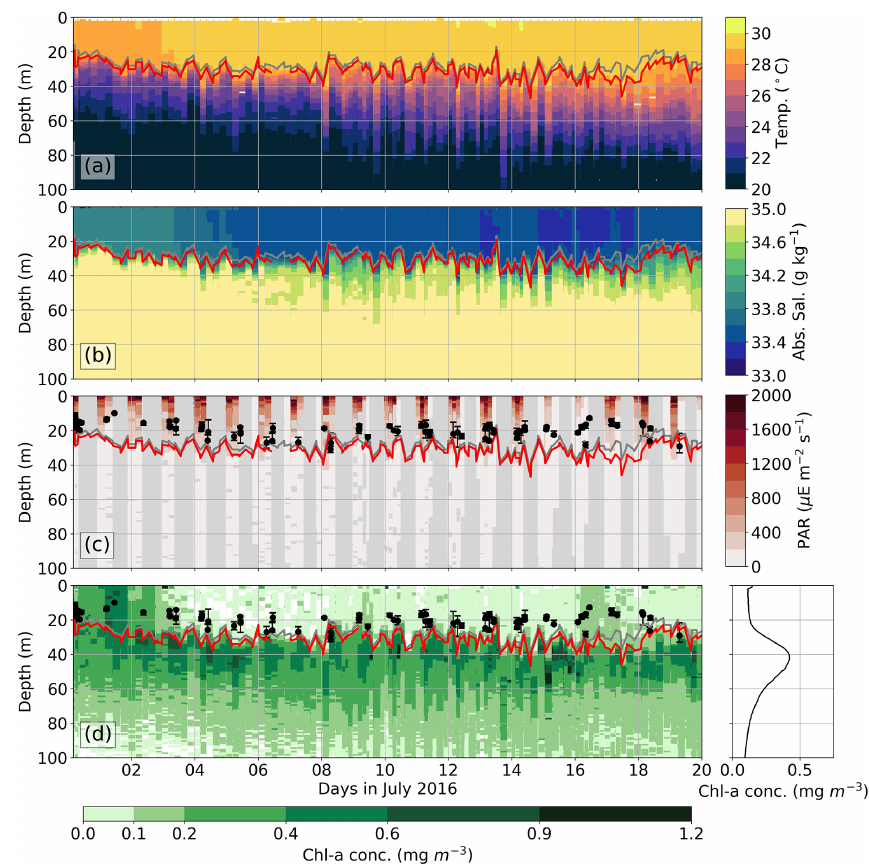
Figure 3. Time series of observations measured by glider SG579, linearly interpolated to 1m depth intervals down to 100m: (a) temperature ( ◦ C), (b) absolute salinity (gkg − 1 ), (c) PAR (µEm − 2 s − 1 ), and (d) chlorophyll concentration with the vertical profile of the average chloro- phyll concentration (mgm − 3 ). The black circles are scale depth values, h 2 (m). The MLD is defined as the depth at which density is same as the surface density plus an increase in density equivalent to a 0.8 ◦ C decrease in temperature, and the isothermal layer depth is calculated as the depth at which temperature is 0.8 ◦ C cooler than SST (Kara et al., 2000; Thushara et al., 2019). The region between the MLD (grey line) and isothermal layer depth (red line) is the barrier